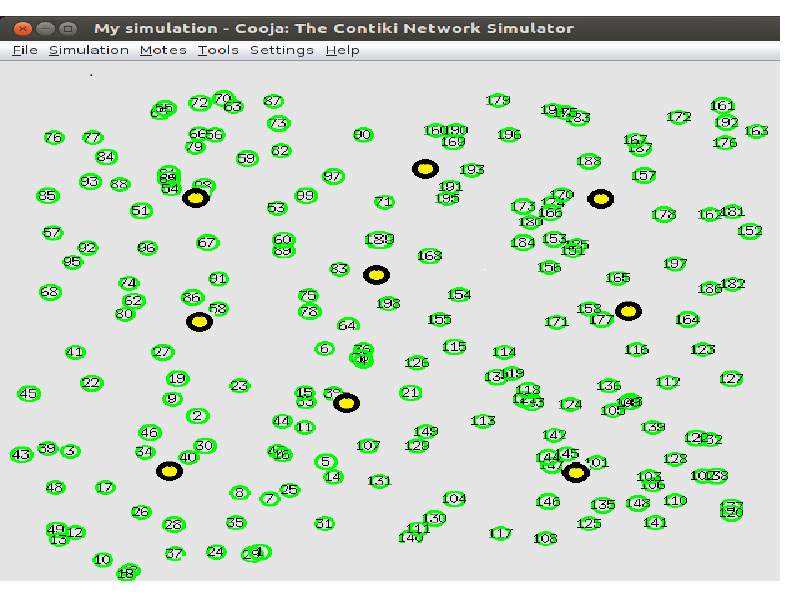
Figure 6. WSN nodes distribution in the Cooja simulator.